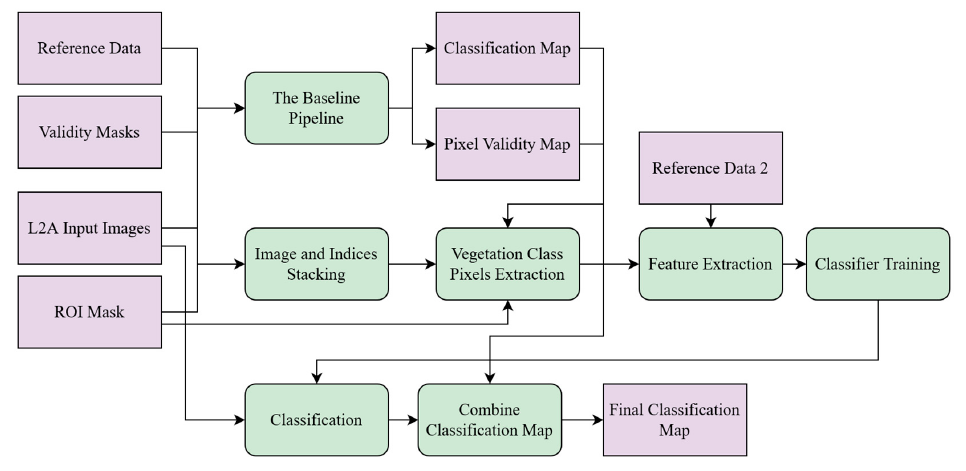
Figure 3. The multi-classifier pipeline.